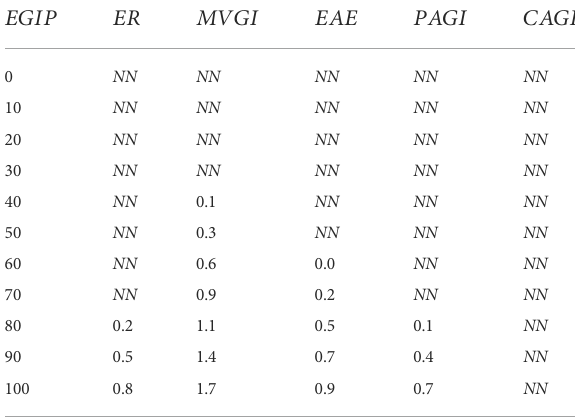
TABLE 3 Necessity tests for individual conditions of the fsQCA